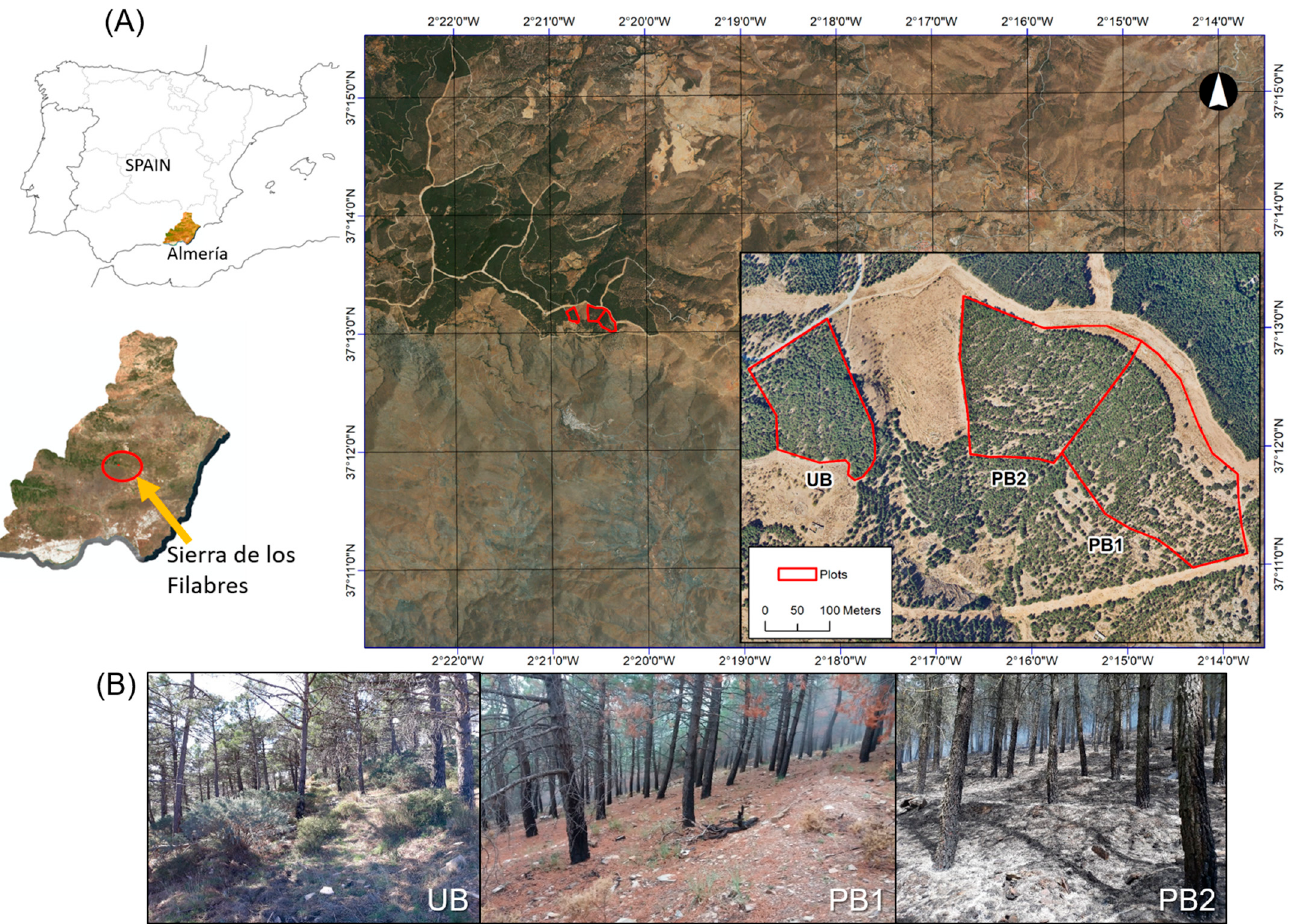
Figure 1. ( A ) Geographical location (southeast Spain, Almería), aerial view of study area with the experimental site. ( B ) Detail view of the di ff erent stands selected at the sample collection date. Unburned stand (UB), burned stand seven months after prescribed burning (PB1), burned stand (PB2).